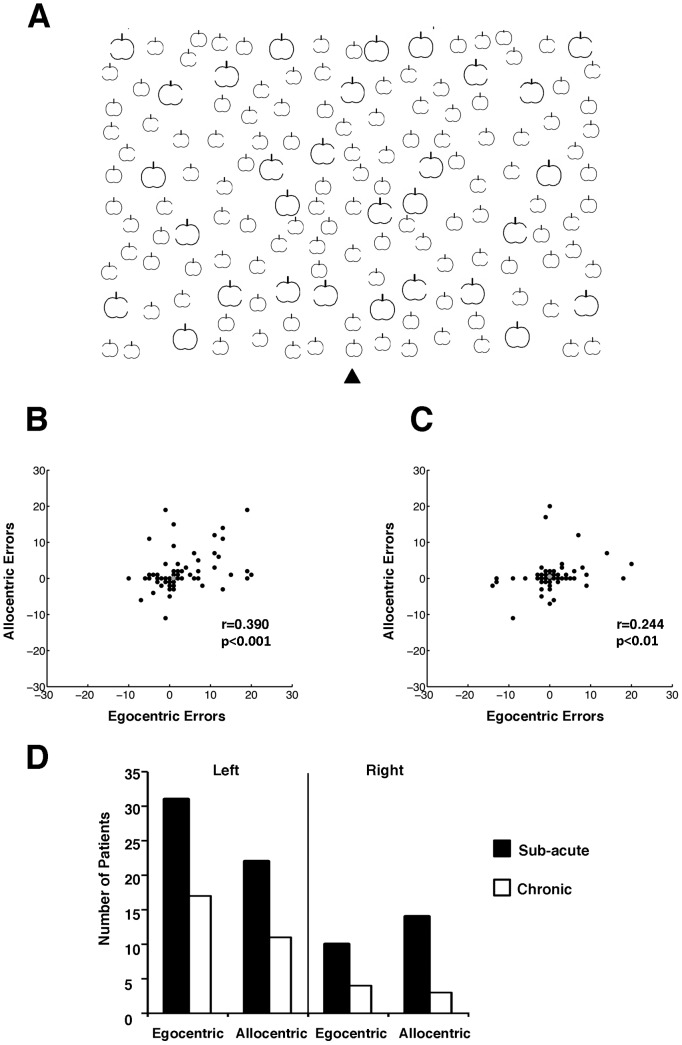
Example of the Apples cancellation task (A) used to simultaneously test for allocentric and egocentric symptoms.In this test patients are asked to cross out all the full apples. Egocentric neglect is measured by whether patients miss targets (full apples) predominantly on one side of the page and allocentric neglect is measured by whether patients make false positive responses by cancelling predominantly left or right distracters (according to the position of the gap defining a distracter; for full details and scoring see the Methods section). (B) and (C) present scatterplots of egocentric neglect errors against allocentric neglect errors at the sub-acute (B) and chronic (C) phases following stroke. There was significant correlation between allocentric and egocentric neglect scores at either phase. Please note that the middle grey dot corresponds to results for non-impaired patients. (D) Behavioural results – the number of patients with egocentric and allocentric neglect symptoms at the sub-acute and chronic phase following stroke.